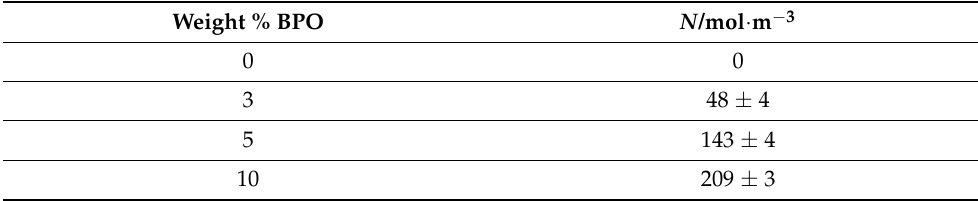
Table 1. Spatial cross-link density of the studied samples.